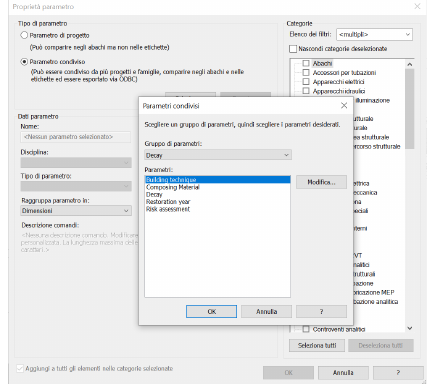
Figure 2 . The creation of the shared parameters.